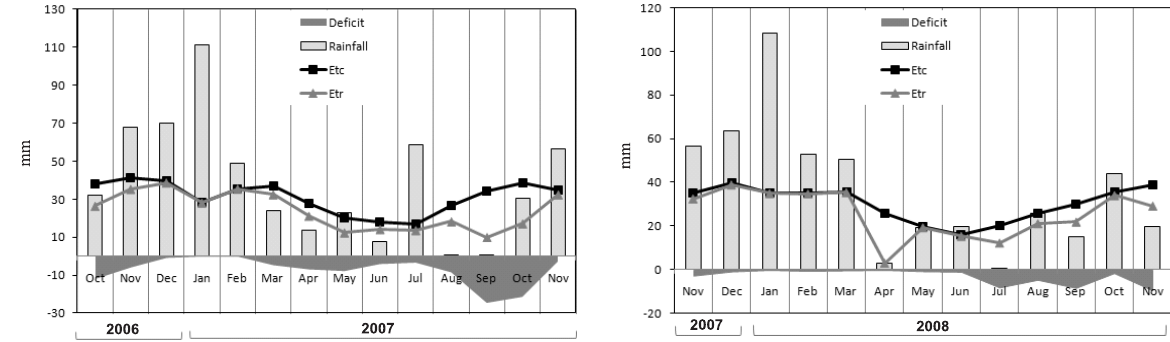
Figure 1. Climatological water balance of the experimental area in the agricultural cycle of the second and third ratoon of sugarcane. ETc: Potential evapotranspiration of the crop; ETr: Real evapotranspiration of the crop; Deficit.: Soil